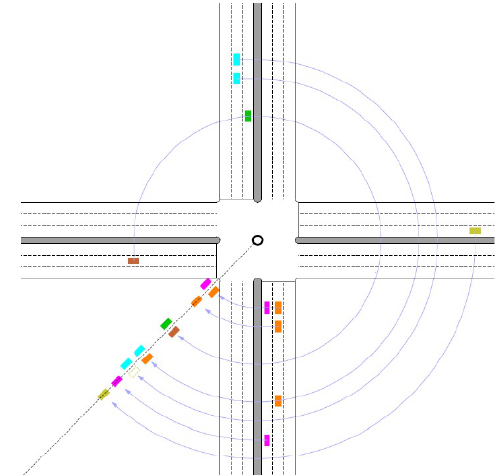
Figure 1. A demonstrative example of a virtual platoon and pairing